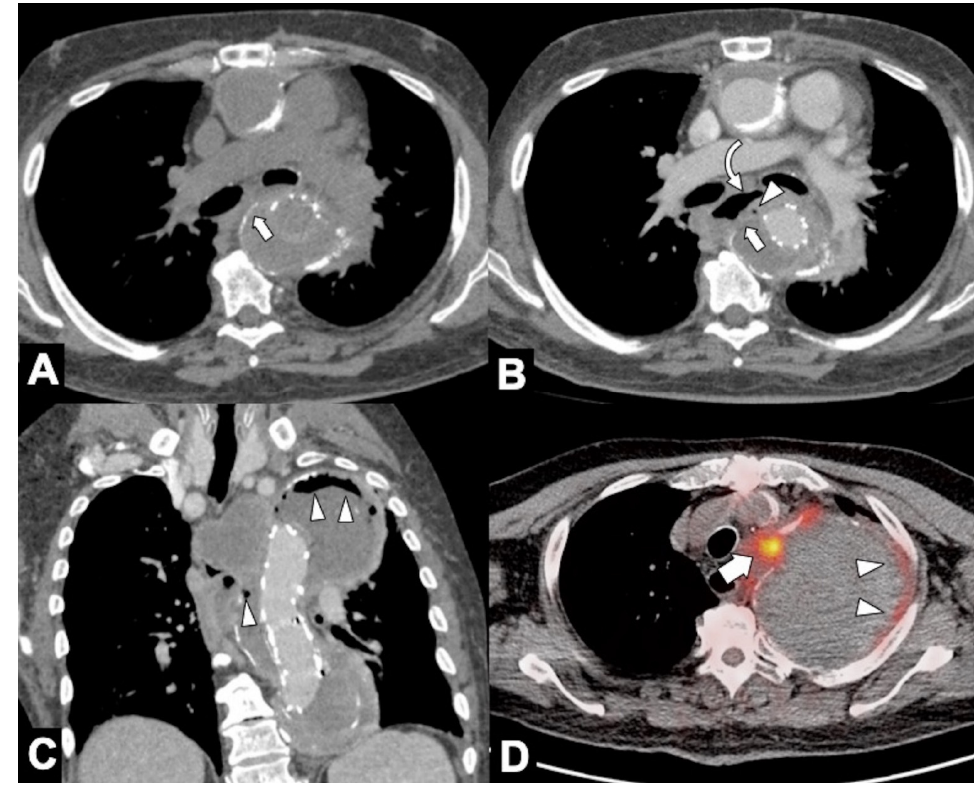
Figure 13. CT evaluation and CT-PET in a 68-year-old male patient with an aortoesophageal fistula (AEF) after 28 days from TEVAR. ( A , B ) CTA evaluation for the onset of fever showing disappearance of thoracic descending aortic wall calcification (arrow), distended esophagus (curved arrow), and appearance of an ectopic small air bubble in the native aneurysmal aortic lumen (arrowhead). ( C ) Coronal oblique MPR image better shows a significant amount of air in the native aortic lumen (arrowheads) due to probable AEF. ( D ) Fused FDG PET-CT axial image shows multiple foci of increased FDG uptake both in the aneurysm wall (arrowheads) both in the mediastinum (arrow) suggestive of infected thoracic aortic aneurysm and TEVAR endograft.